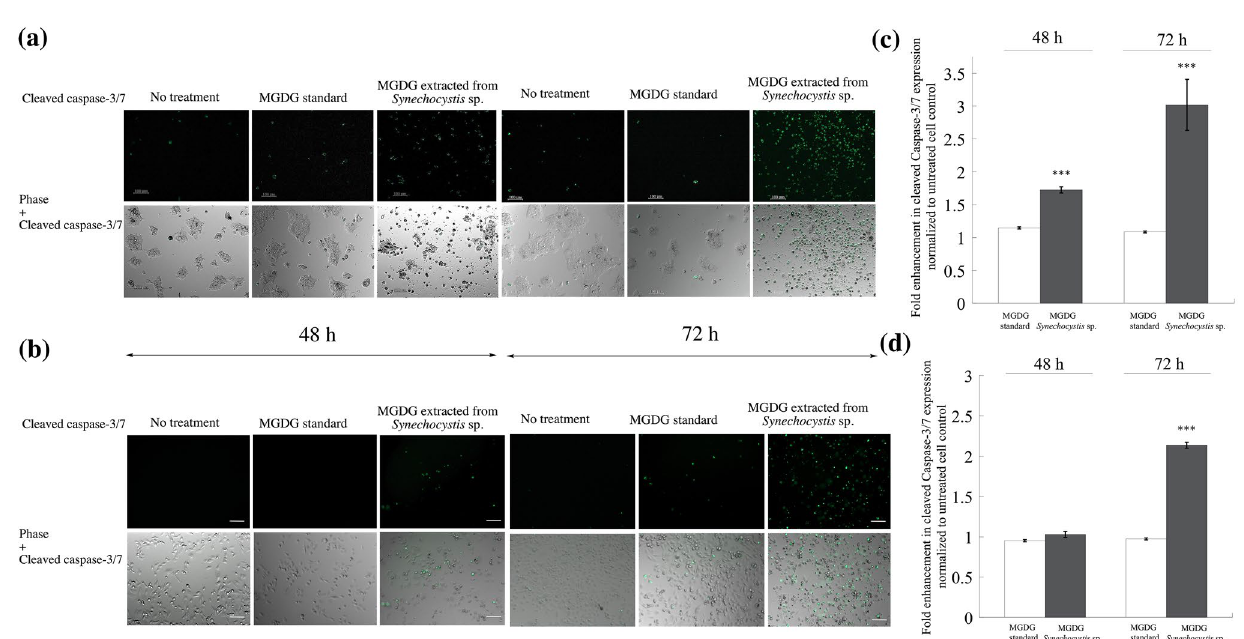
Figure 7. In vitro anti-cell proliferation analysis of MGDG extracted from Synechocystis sp. PCC 6803 (solid line) and MGDG standard (dotted line) in ( a ) BT-474 and ( b ) MDA-MB-231 cell lines. Mean percentage values are presented from six replicates (n = 6) for each drug dosage. The MGDG from the Synechocystis sp. inhibits up to 70% ( p < 0.001) and 60% ( p < 0.001) of BT-474 and MDA-MB-231 cancer cells, respectively where MGDG standard does not show any toxicity within the concentration range of 0–200 ng/ml. *** indicates the p value < 0.001 showing a statistically significant difference between % cell death in MGDG extracted from the Synechocystis sp. and MGDG standard. ( c ) MGDG extracted from the Synechocystis sp. does not show any cytotoxic side effects in human dermal fibroblasts normal cell line control.